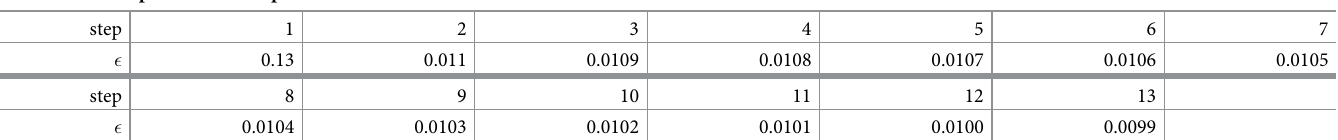
Table 4. Value of epsilon for all steps of the ABCPMC.